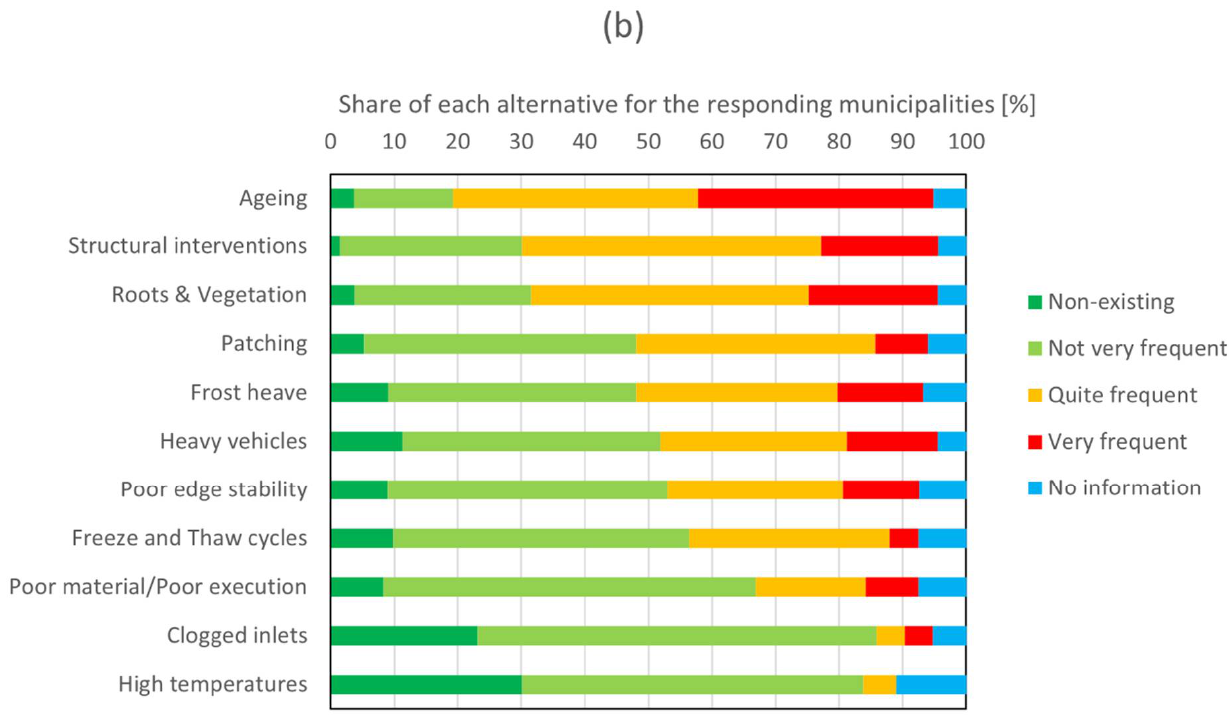
Figure 7. Stated causes of distress on the municipal ( a ) street- and ( b ) cycle-path network. The response rate varies for the different distress causes and is marginally higher for streets (n = 136–140) than for cycle paths (n = 133–136).